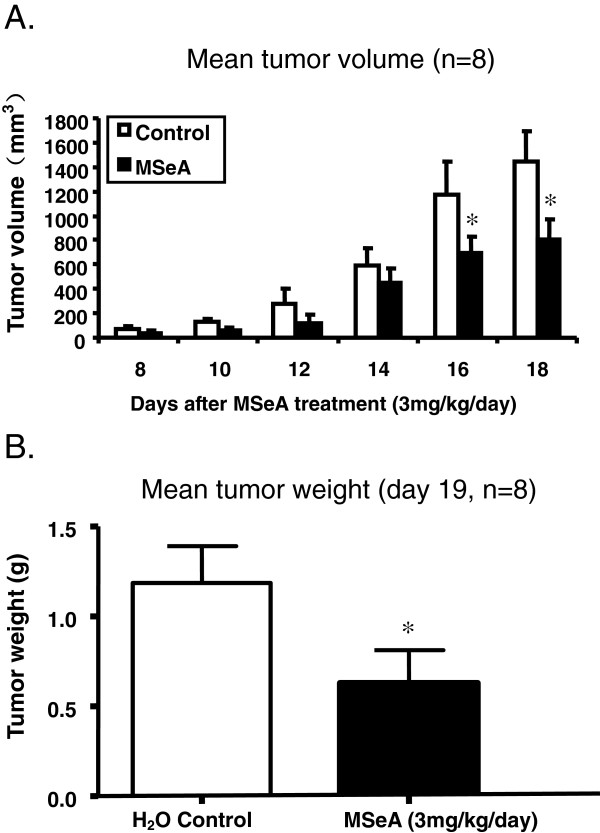
Mean tumor volume (A) and tumor weight (B) of MDA-MB-231 mammary cancer cell induced xenografts were significantly lower (p < 0.05) in athymic nude mice receiving single dose oral administration of MSeA at 3 mg/kg/day. Control animals received no oral administration of MSeA.